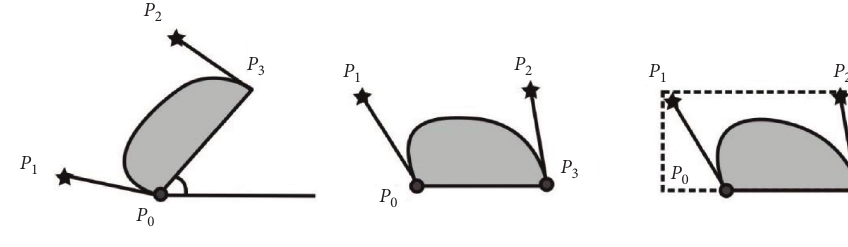
Figure 4: Normalization process.